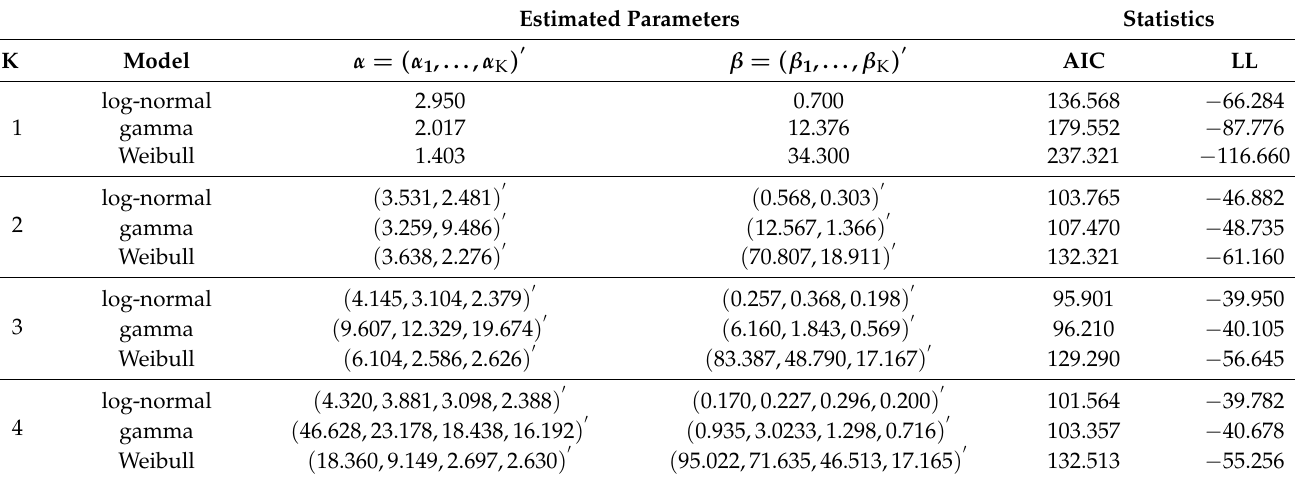
Table 4. Parameter estimates and goodness-of-fit statistics for the mixture of log-normal, gamma, and Weibull distributions fitted to sample 3 in grouped case when class width is 5 cm. It should be noted that the estimated vector of mixing parameters is not given for the sake of saving space.